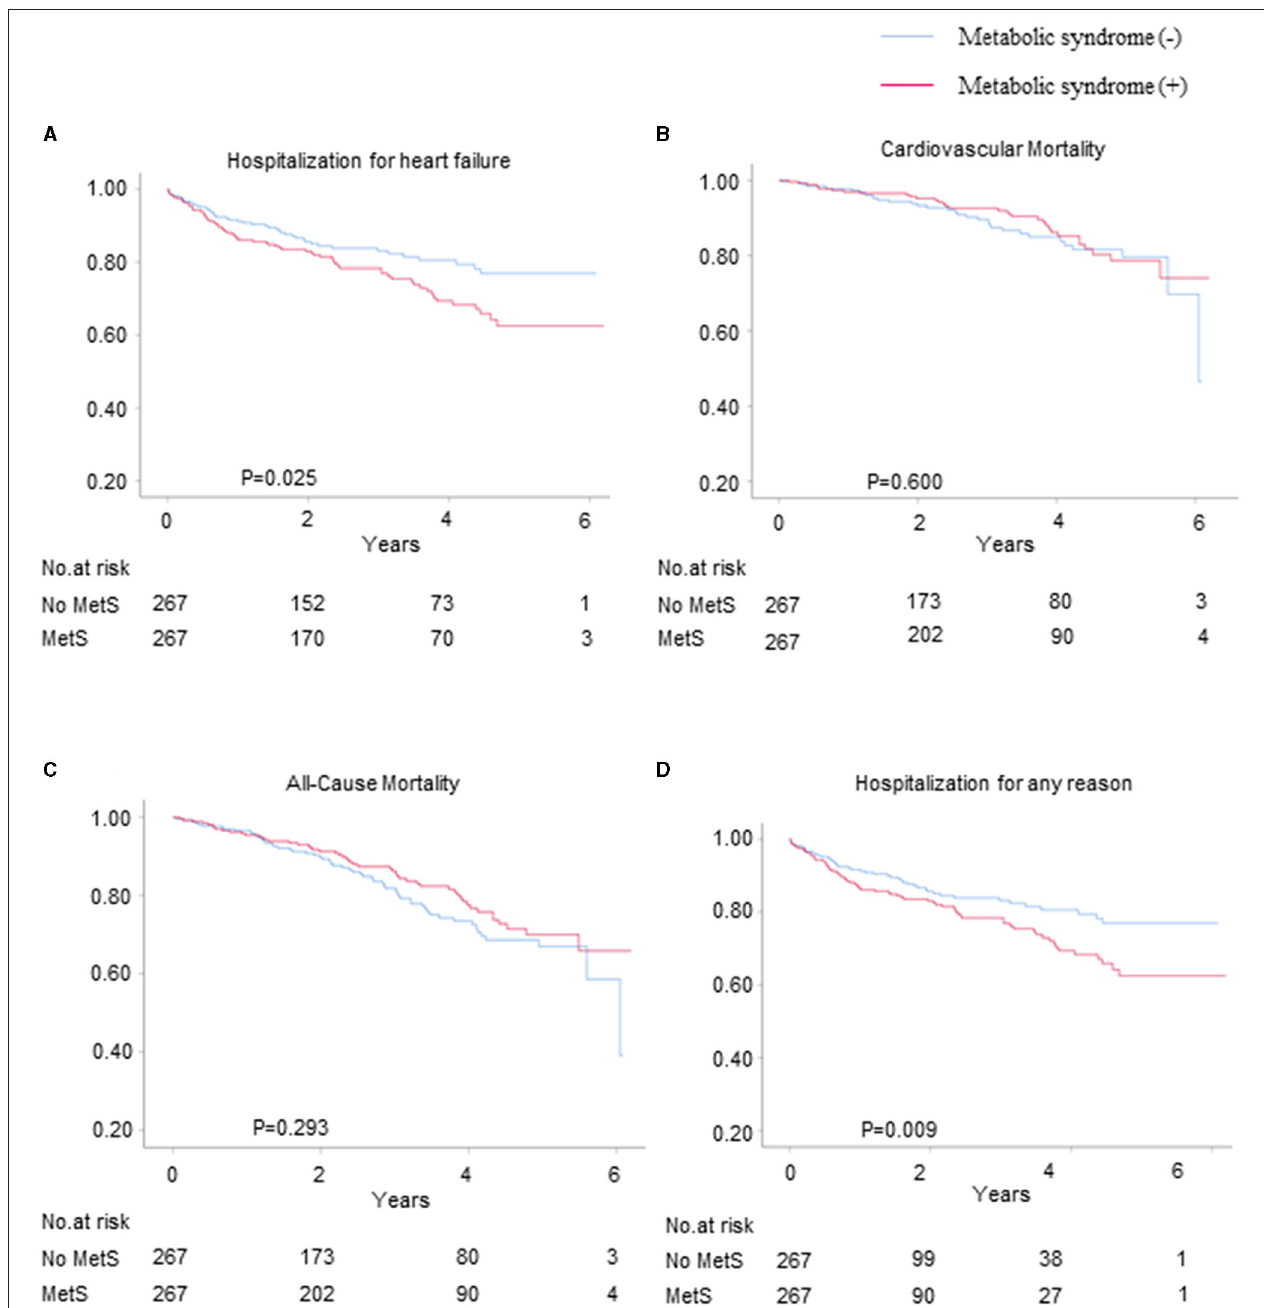
FIGURE 3 | The Kaplan–Meier survival curves for the primary and secondary outcomes for the propensity score-matched patients with and without metabolic syndrome. The hospitalization rates for (A) HF, (B) CV mortality, (C) all-cause mortality, and (D) hospitalization for any reason. these pathological processes may contribute to LV diastolic function